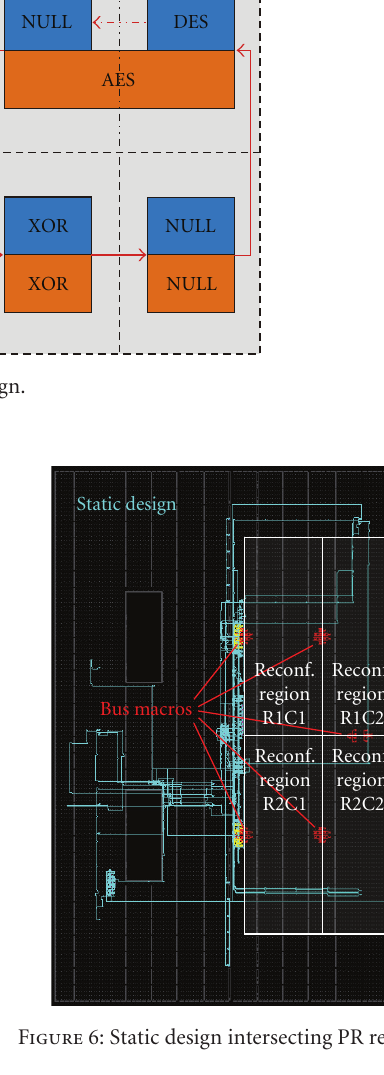
Figure 4: Two scenarios (PlanAhead floor-plans).